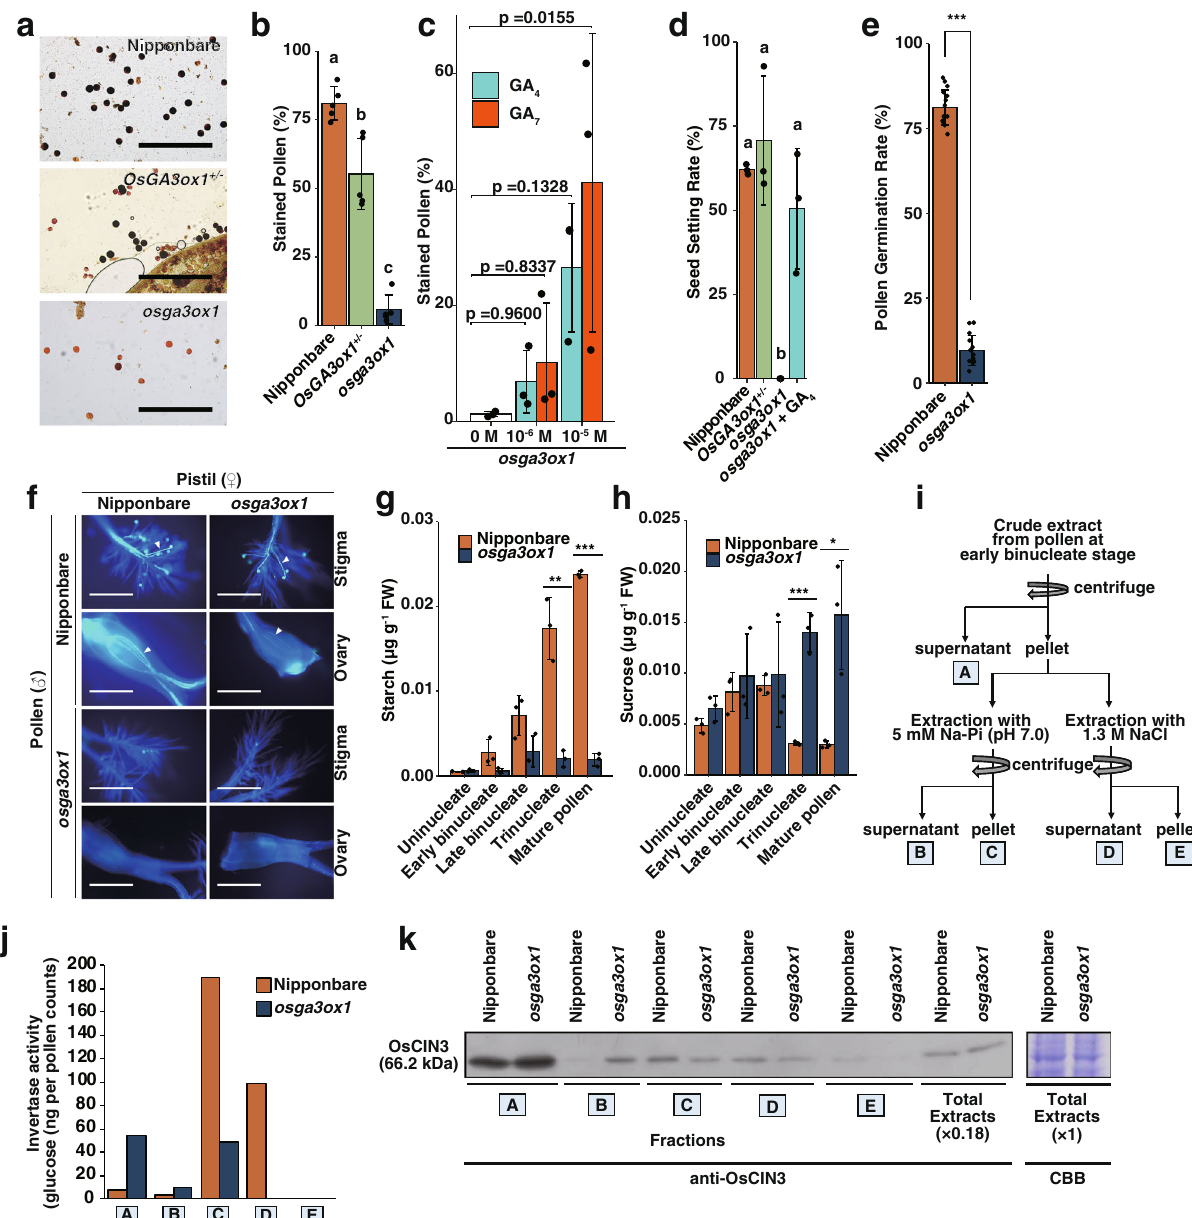
Fig. 2 Phenotypic analysis of the reproductive organs of osga3ox1 mutant rice. a , b Pollen viability test of Nipponbare, OsGA3ox1 + / − (heterozygous), and osga3ox1 mutant performed by conducting staining with the I 2 -KI solution. Pollen grains stained black are deemed viable; those stained red are deemed sterile (Bars = 0.5 mm) ( a ). Percentage of viable vs sterile ( n = 5) ( b ). c Pollen viability test of GA-treated osga3ox1 mutant performed by conducting I 2 -KI staining, same as that for panel ( b ) ( n = 3). P -values by Dunnett ’ s multiple comparison test are indicated. d Seed setting rate of Nipponbare, OsGA3ox1 + / − , osga3ox1 , and GA 4 -treated osga3ox1 mutant plants ( n = 3). e In vitro pollen tube germination of Nipponbare and osga3ox1 mutant ( n = 15). f Reciprocal crossing test between Nipponbare and osga3ox1 mutant plants. Arrowheads indicate pollen tubes. Bars = 0.5 mm. g , h Endogenous quantities of starch ( g ) and sucrose ( h ) contents in anthers of Nipponbare and osga3ox1 mutant ( n = 3). i , j Enzyme activity of acid invertase in extractions from Nipponbare and osga3ox1 mutant pollen in the early binucleate stage. Summary of the extracted fractions ( i ) and their invertase activities ( j ) (these experiments were repeated three times with similar results). k Western blot analysis of OsCIN3 in extracted fractions in ( I ) and total extract of anthers using an OsCIN3 speci fi c antibody. CBB staining of total extract is also shown. In all experiments, error bars = s.d. For panels ( b ) and ( d ): one-way ANOVA with Tukey ’ s multiple comparisons test. Different letters denote signi fi cant differences ( p < 0.001). For panels ( e ), ( g ), and ( h ): *** p < 0.001, ** p < 0.01, and * p < 0.05 by two-tailed paired t